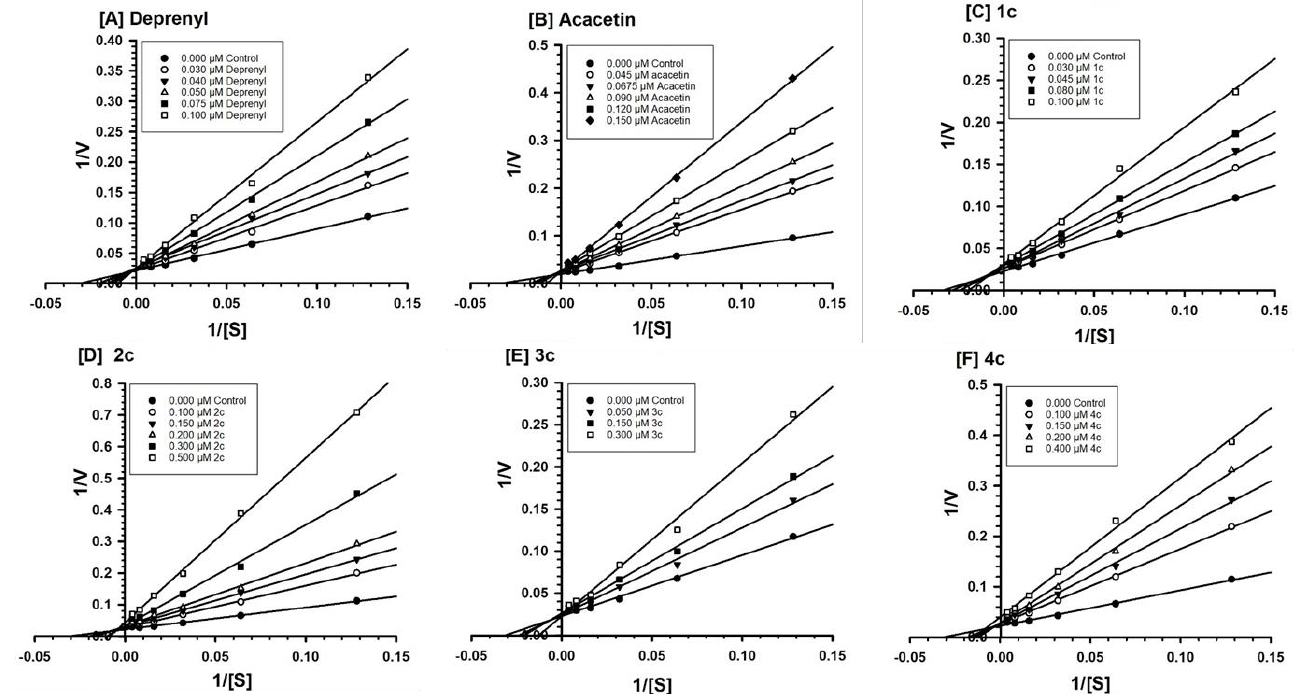
Figure 7. Kinetic characteristics of inhibition of recombinant human MAO-B with [ A ] deprenyl [ B ] acacetin, [ C ] 1c , [ D ] 2c , [ E ] 3c, and [ F ] 4c; V = nmoles/min/mg protein and S = substrate kynuramine concentration (μM).